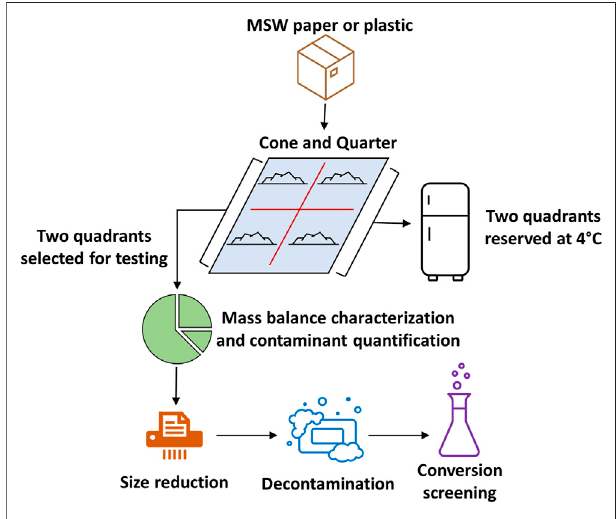
FIGURE 1 | Flow diagram depicting MSW sample preparation and